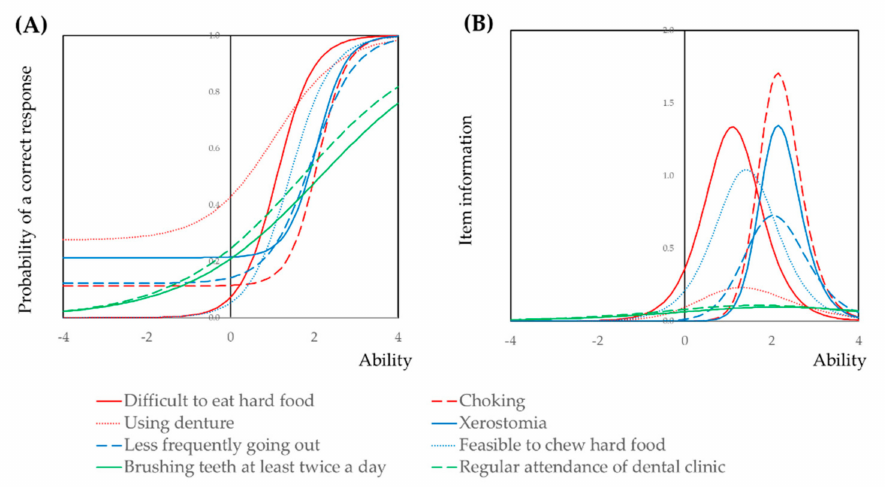
Figure 2. Item response curves and item information curves of items of the oral frailty screening questionnaire. Three parameter logistic models were applied separately by the latent variable shown in Table S2. The item response curve of the “Brushing teeth at least twice a day”, “Regular attendance of dental clinic”, and “Using denture,” are gentle. The item information of these items are low. The item response curves of “Difficult to eat hard food”, “Feasible to chew hard food”, are located in backward direction when compared to those of “Choking”, and